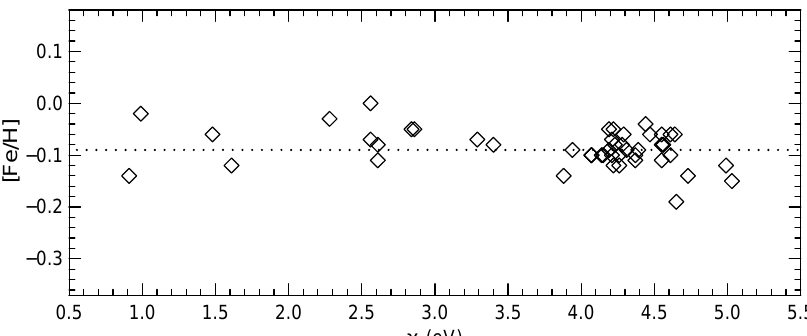
Fig. 2. The [Fe i /H] abundance values versus the lower excitation potential (cid:31) l . The mean abundance ([Fe i /H] = –0.09 dex) is shown as a dotted line.